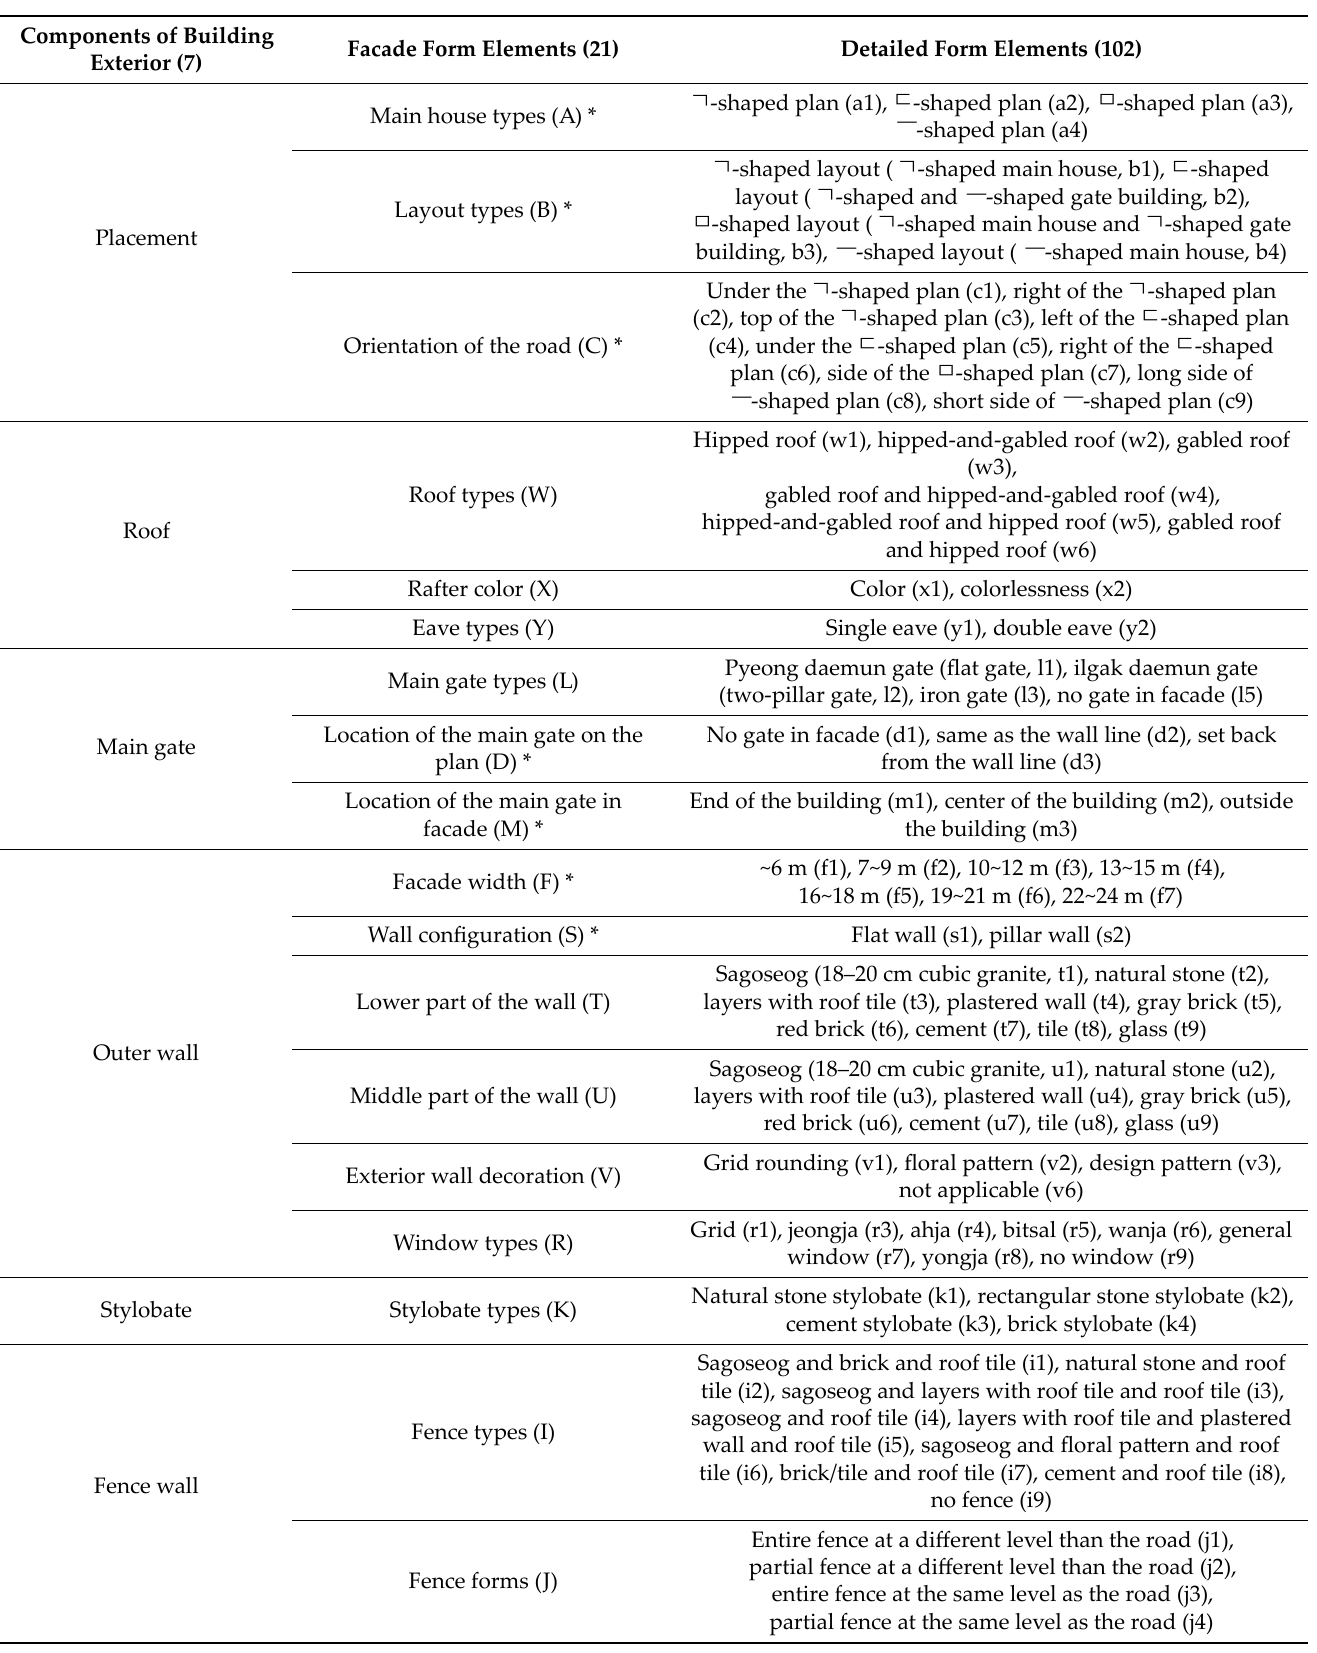
Entire fence at a different level than the road (j1), partial fence at a different level than the road (j2), entire fence at the same level as the road (j3),